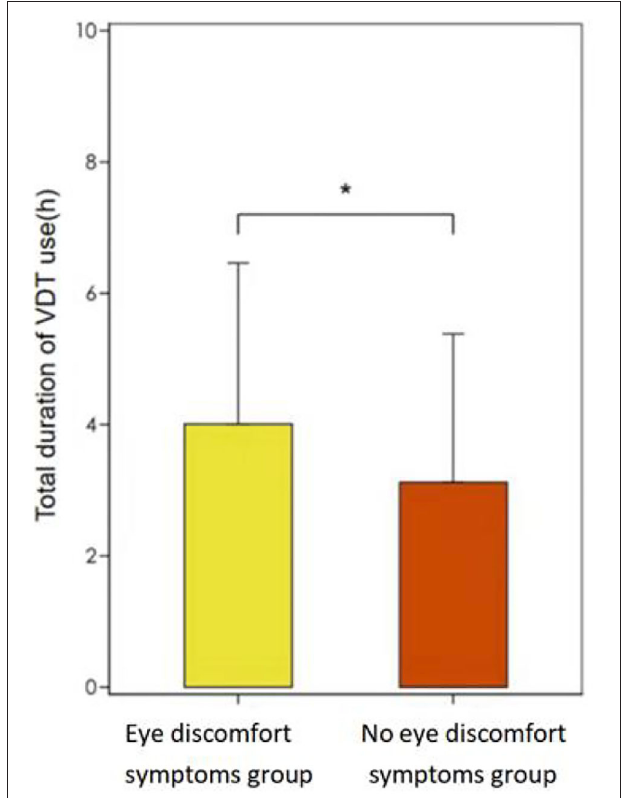
FIGURE 2 | Total sleep time, eye discomfort symptoms group vs. no eye discomfort symptoms